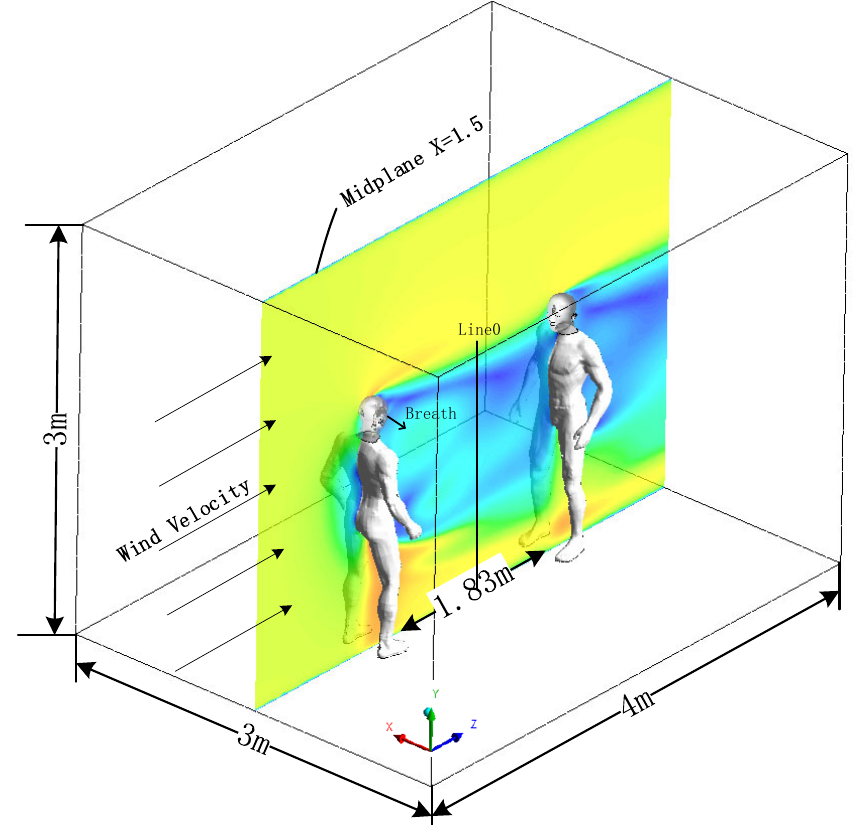
Figure 1. Schematic of the computational domain with two virtual humans .